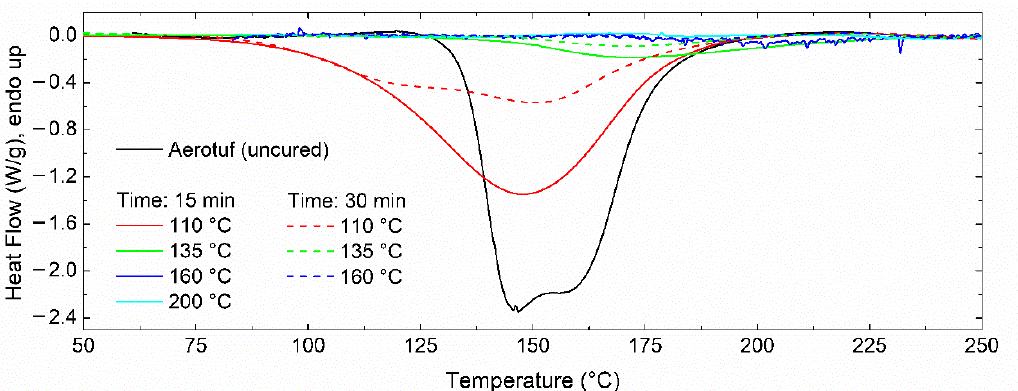
Figure 11. Non-isothermal DSC curves of the Aerotuf resin at different curing times and temperatures. Heating rate: 10 °C/min. Table 3. Calculated values for resin samples cured at different times and temperatures.